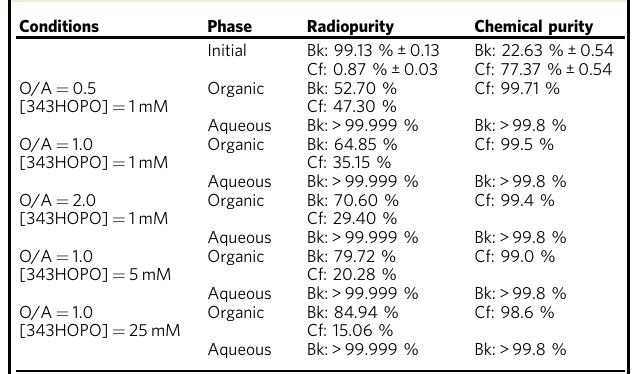
Table 1 Separation of 249 Bk and 249 Cf at the mCi level using TODGA and 343HOPO a